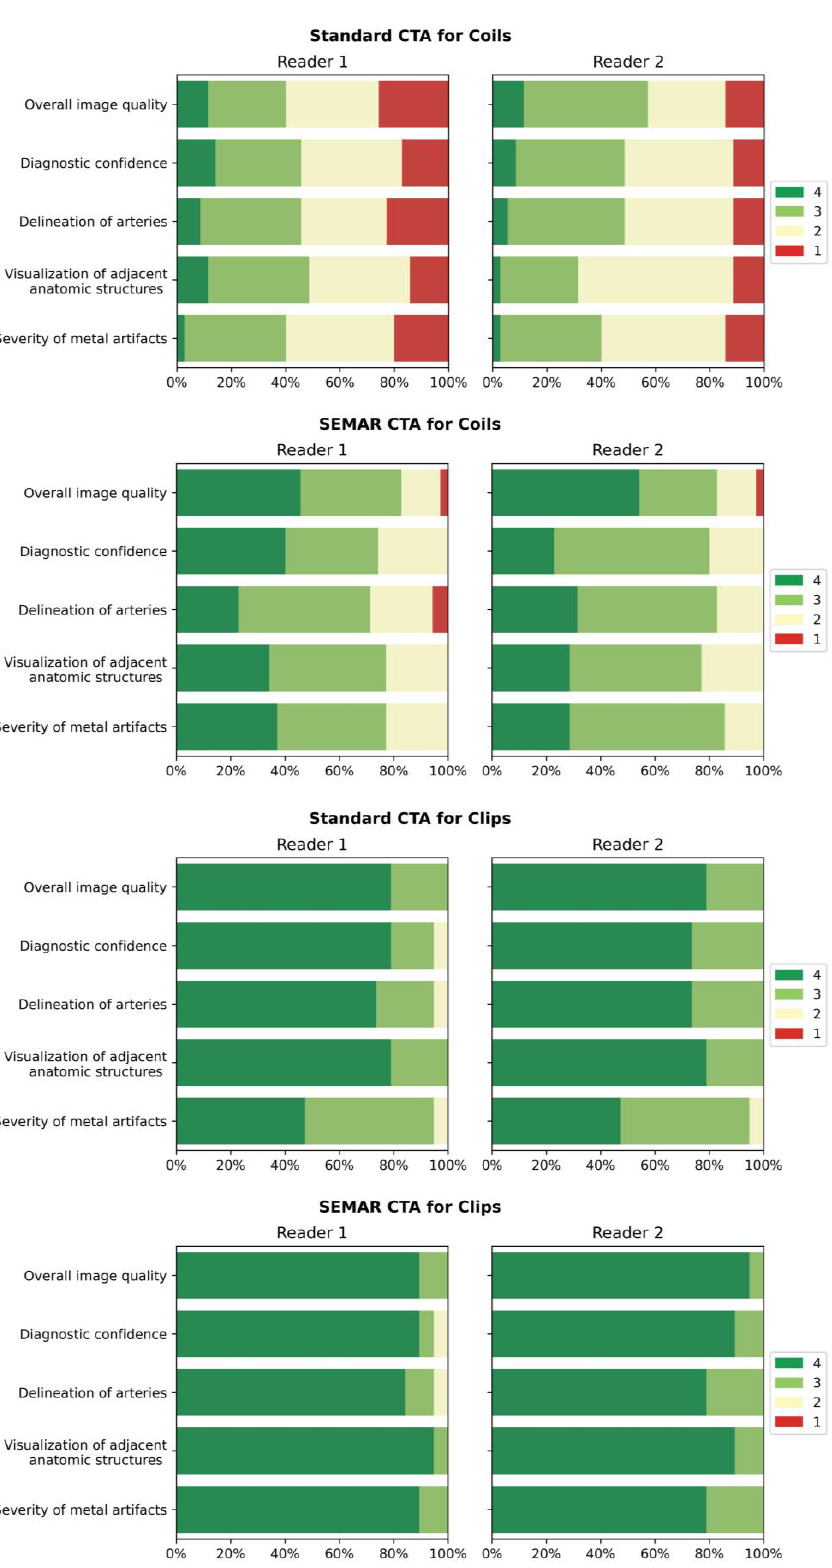
Figure 6. Bar-charts of Likert scale values (4 being best) rated by the readers for both standard and SEMAR CTA images with coil/clip artifacts demonstrate the distribution for the following categories: overall image quality, diagnostic confidence, delineation of arteries, visualization of adjacent anatomic structures, and severity of metal